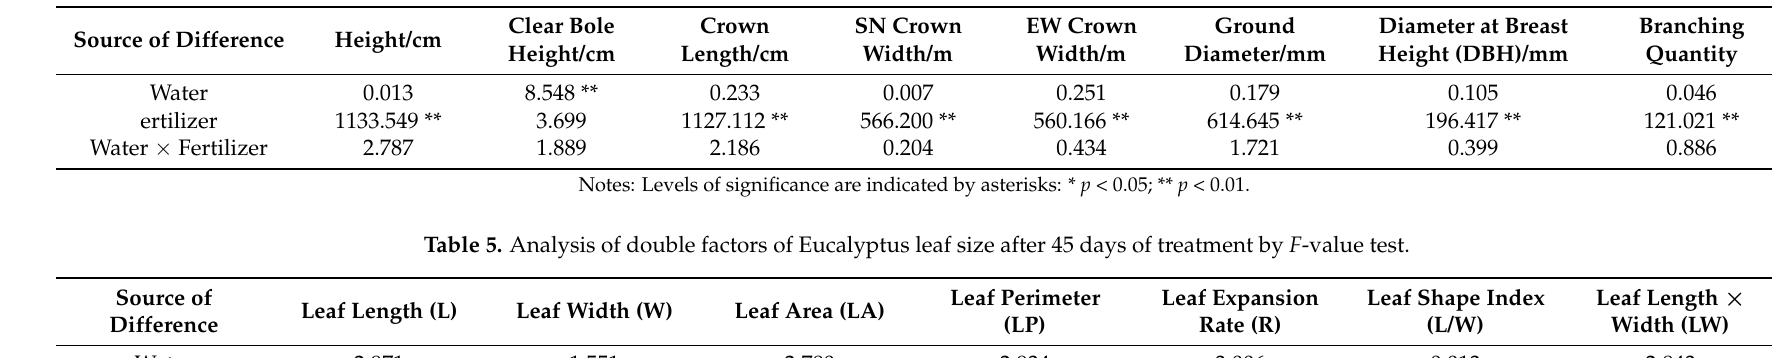
Table 4. Analysis of double factors of Eucalyptus growth after 45 days of treatment by F -value test ( F value).